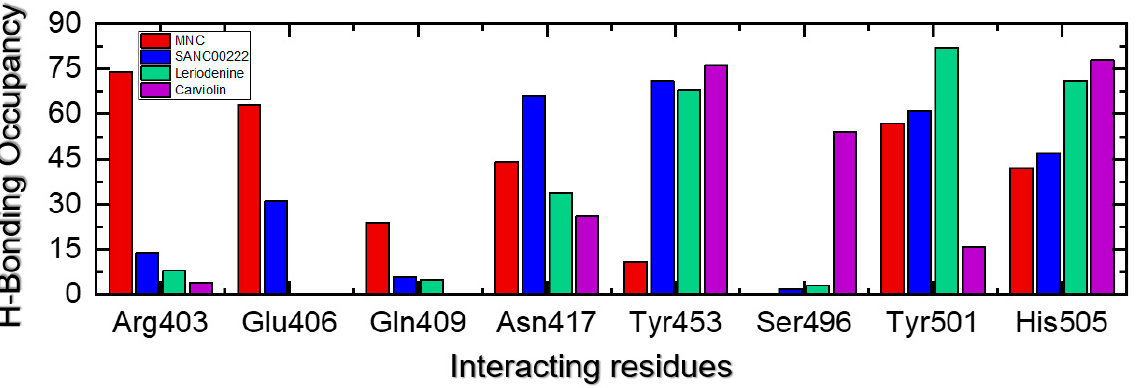
Figure 9. Hydrogen-bonding occupancy calculation for each complex during the 300 ns of the simulation time period.